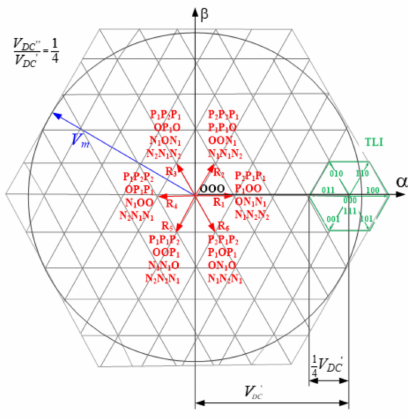
Figure 6. Five-level inverter (5LI) + TLI voltage space vector diagram ( V DC (cid:48)(cid:48) / V DC (cid:48) =